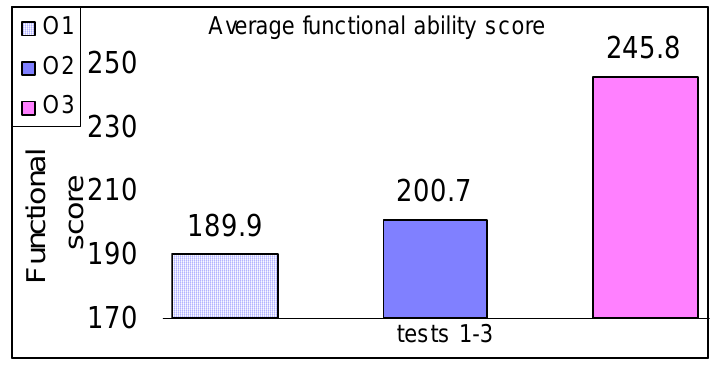
FIGURE 3. Average change in functional scores. The figure represents the average functional scores for all participants (n = 15) at tests O 1 (2 months before program